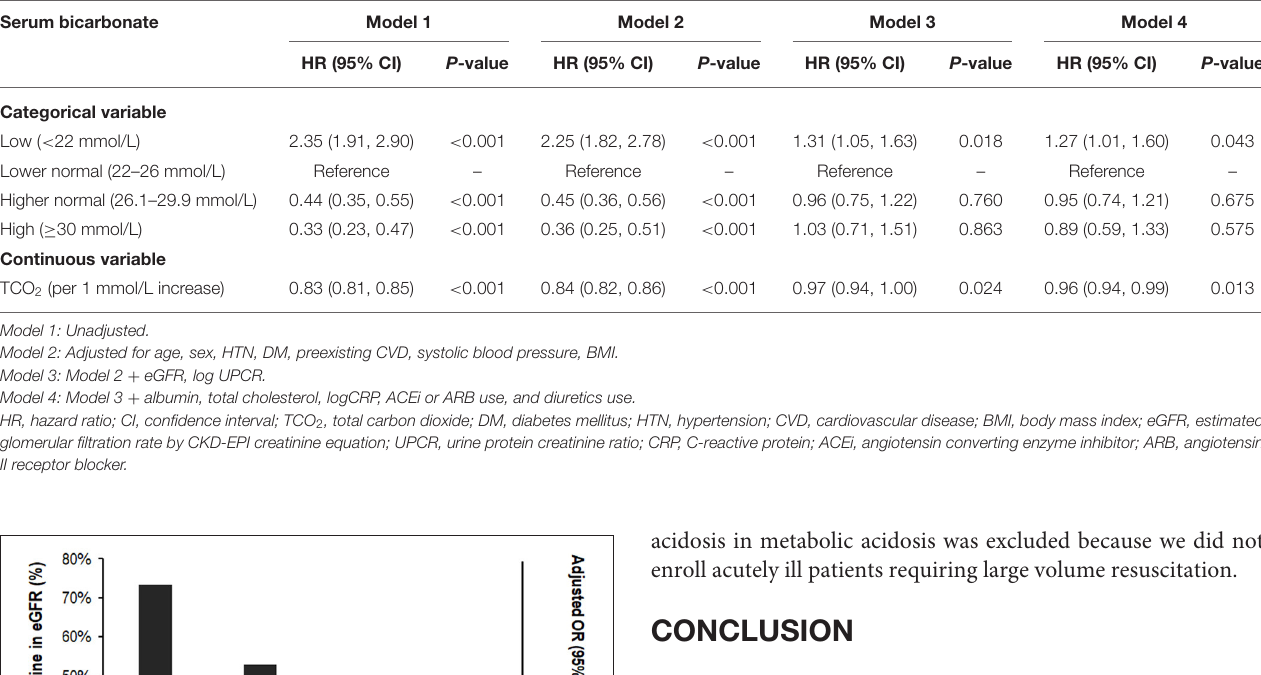
TABLE 3 | Renal events according to serum bicarbonate